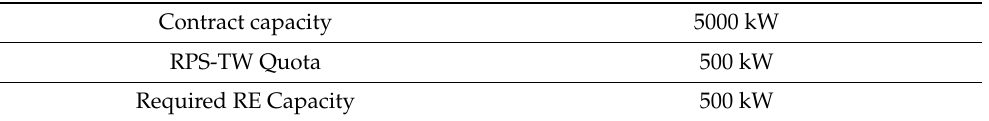
Table 6. Sample calculation: RE installation